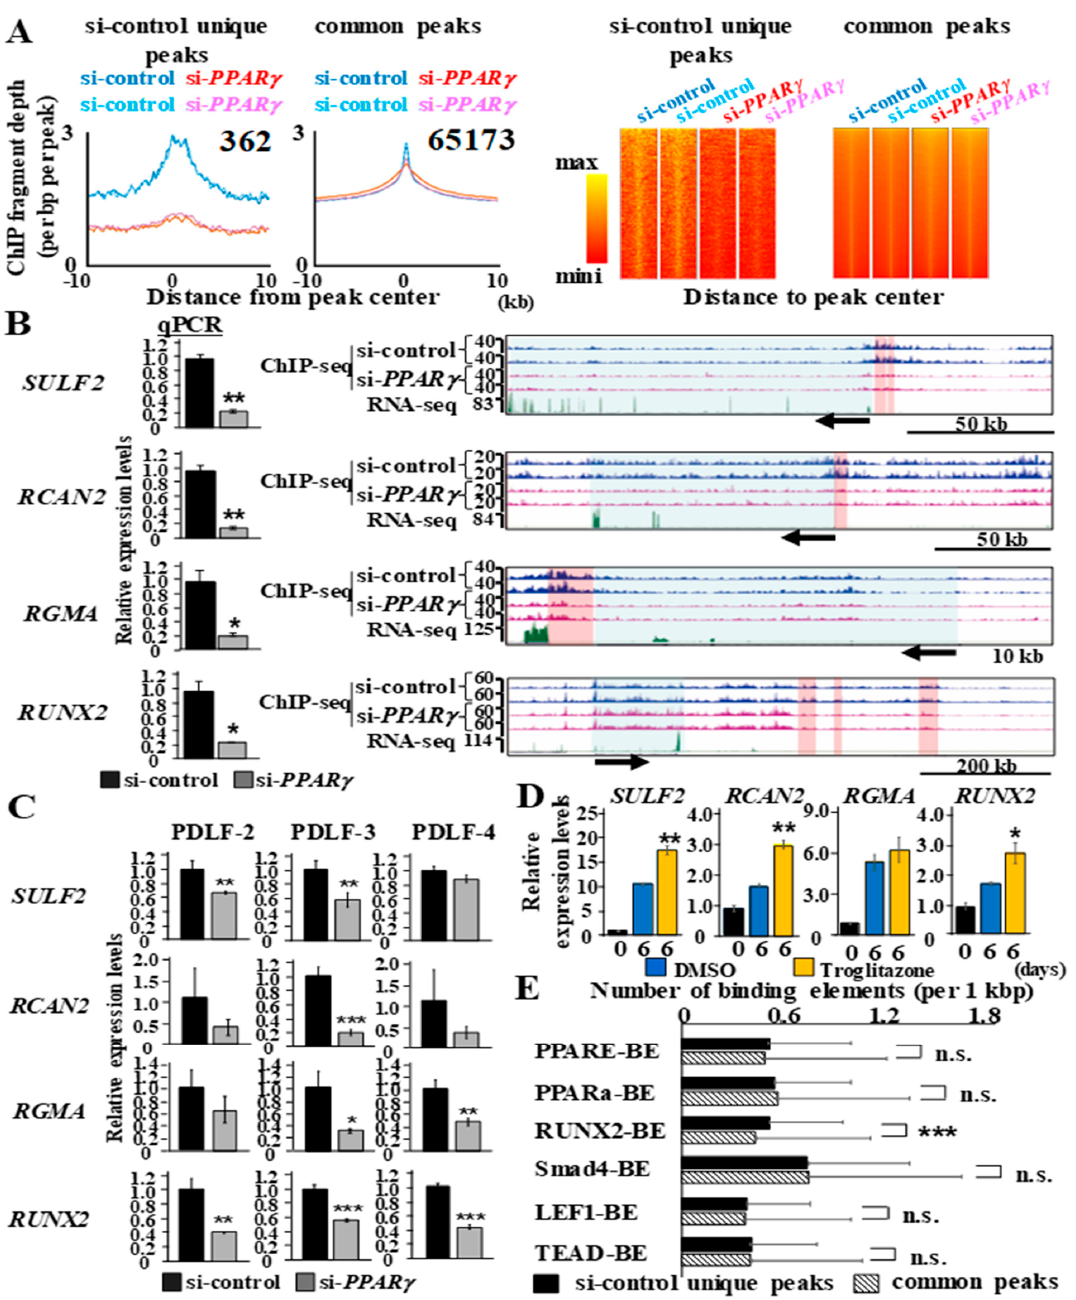
Figure 6. Local genomic peaks retained by PPAR γ include significantly higher numbers of RUNX2-binding sites. ( A ) Histograms represent the occurrence of H3K27ac peaks within 10 kb of the ‘si-control unique peak’ and ‘common peak’ centers. A heat map comparing the binding of technical duplicate tags from PDLF-1 transfected with either si-control or si- PPAR γ within 10-kb windows surrounding the ‘si-control unique peak’ and ‘common peak’ centers. ( B ) qPCR analysis is shown as a bar graph. UCSC genomic browser tracks of each gene locus showed a gene locus (blue background) and H3K27ac peaks identified as ‘si-control unique peaks’ (red background). Arrows indicate transcriptional direction. ( C ) PDLF-2, PDLF-3, and PDLF-4 were transfected with si-control or si- PPAR γ and SULF2 , RCAN2 , RGMA , and RUNX2 mRNA expression at 24 h after transfection was analyzed using HPRT for normalization. ( D ) PDLF-1 were cultured in induction medium for 6 days in the presence or absence of troglitazone (5 μ M) to quantify the expression of SULF2 , RCAN2 , RGMA , and RUNX2 . HPRT was used for normalization. ( E ) The number of PPAR γ -binding elements (PPARE-